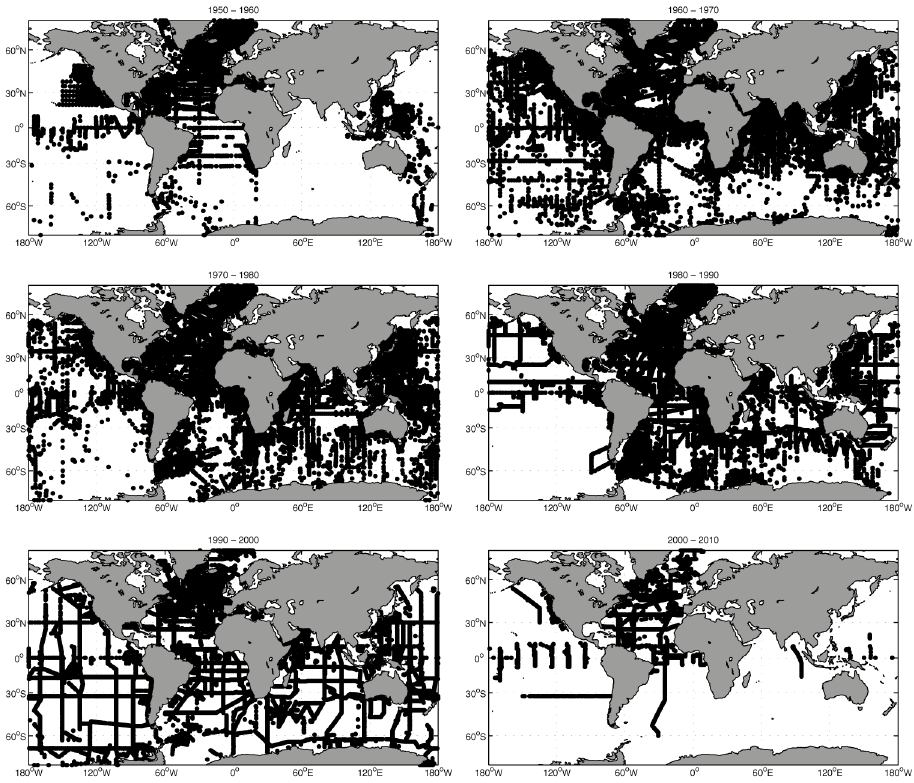
Fig. 1. Distribution of 300 dbar dissolved oxygen data for the decades 1950 to 1960 (upper left frame) to 2000 to 2010 (lower right frame). 3 a terrestrial vegetation and carbon cycle component.